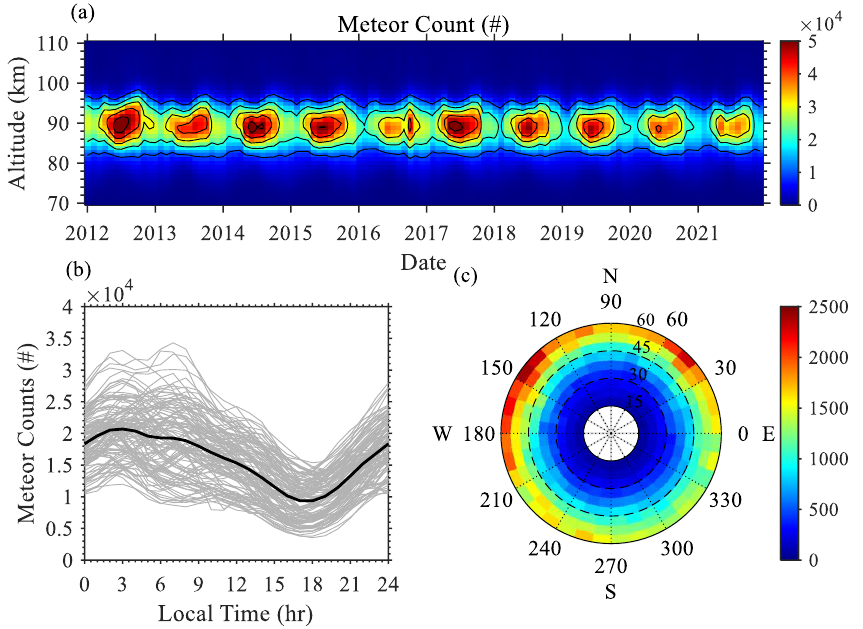
Figure 1. ( a ) Altitudinal variation of the selected meteor counts (#) in each month for the period between 2012 and 2021. ( b ) Local-time variation of the meteor counts in a 1-h bin for each month (grey). The black line is the average value. ( c ) Azimuth-zenith distribution of the meteor counts in January